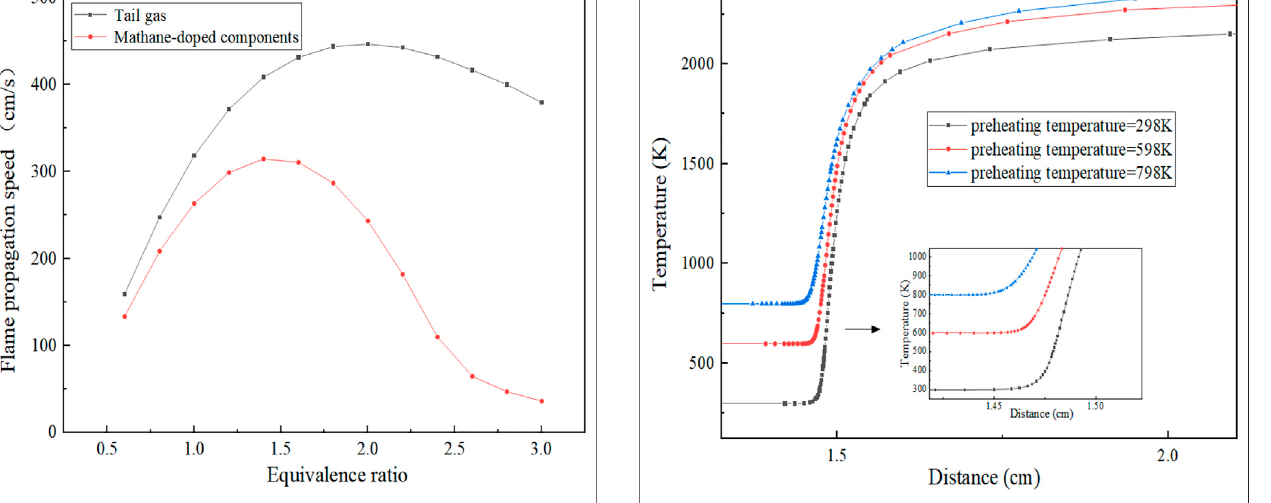
FIGURE 8 | Comparison of fl ame propagation speed law. FIGURE 9 | Variation of fl ame temperature with preheating